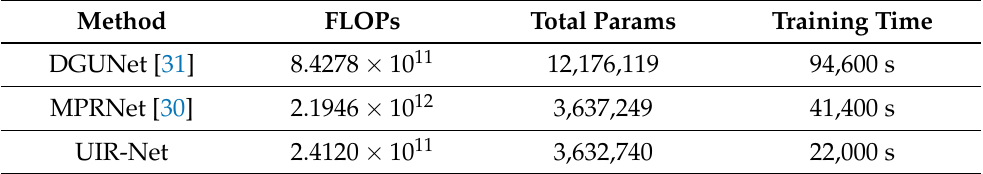
Table 4. FLOPs and Params comparisons.